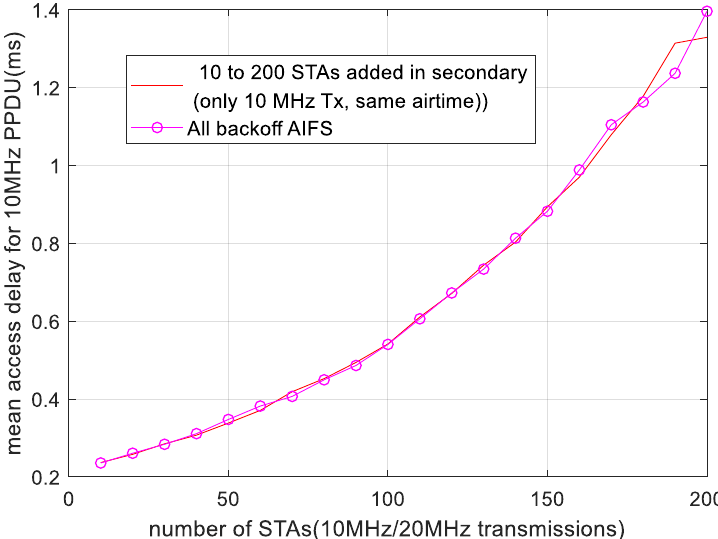
Figure 11. Performance comparison between 10 MHz transmission and 20 MHz transmission under the same channel load.